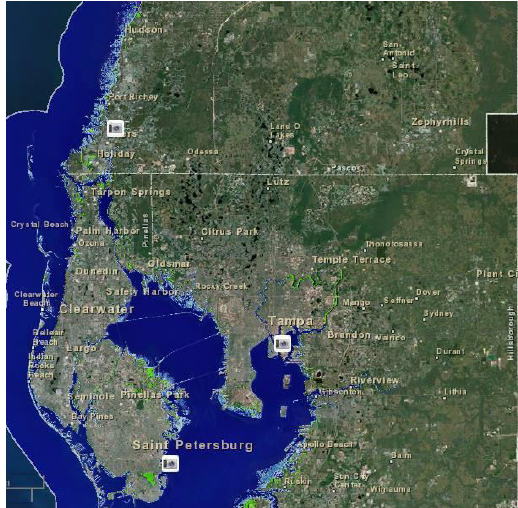
Level Rise Scenario